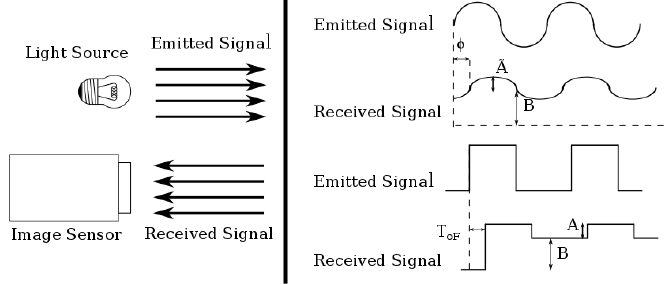
Figure 1. Emitted and reflected light signals in a ToF sensor.